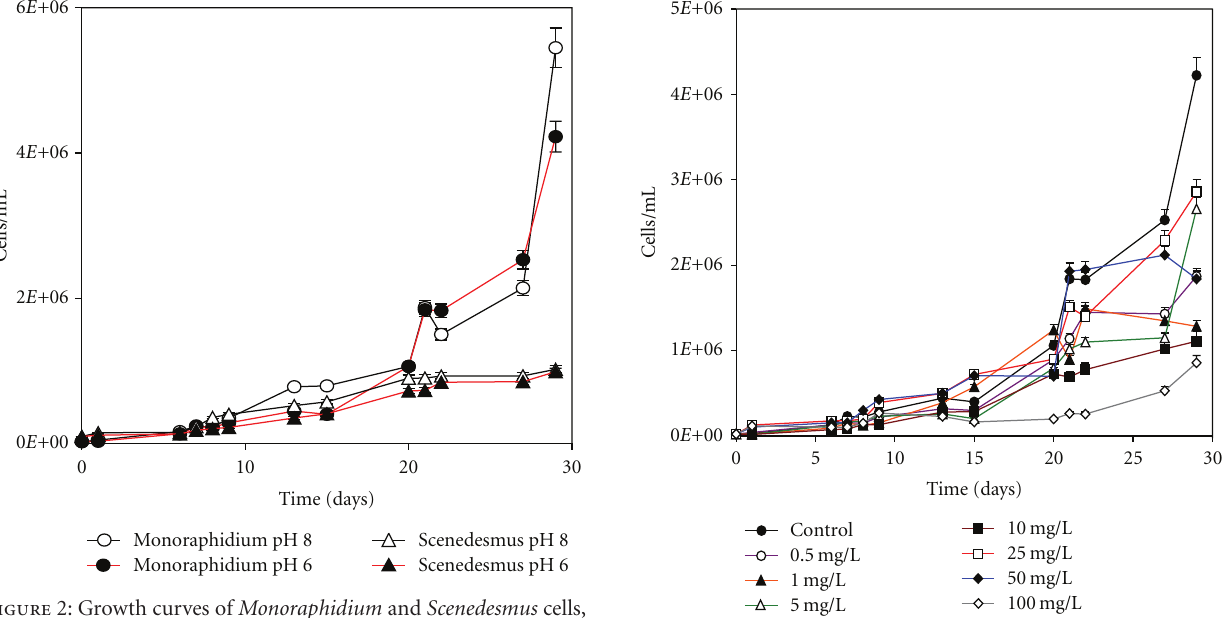
Figure 3: Monoraphidium sp. growth in the absence and presence of thorium up to 100.0